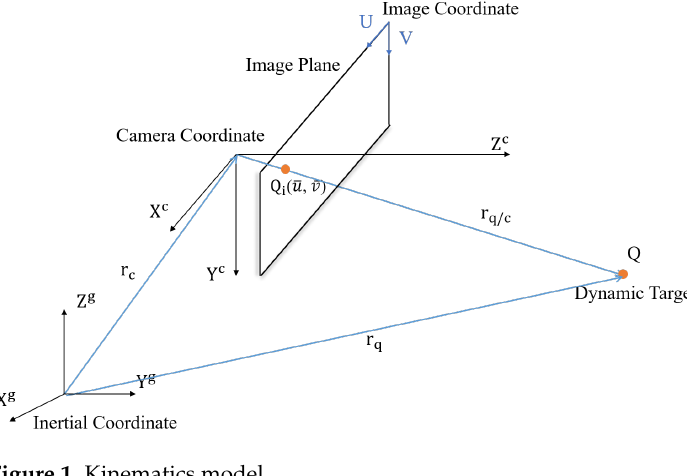
Figure 1. Kinematics model.